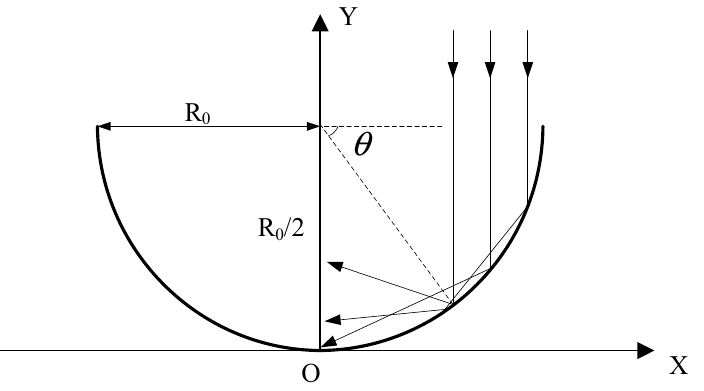
Figure 1. Configuration of the concentrator in 2-D plane.